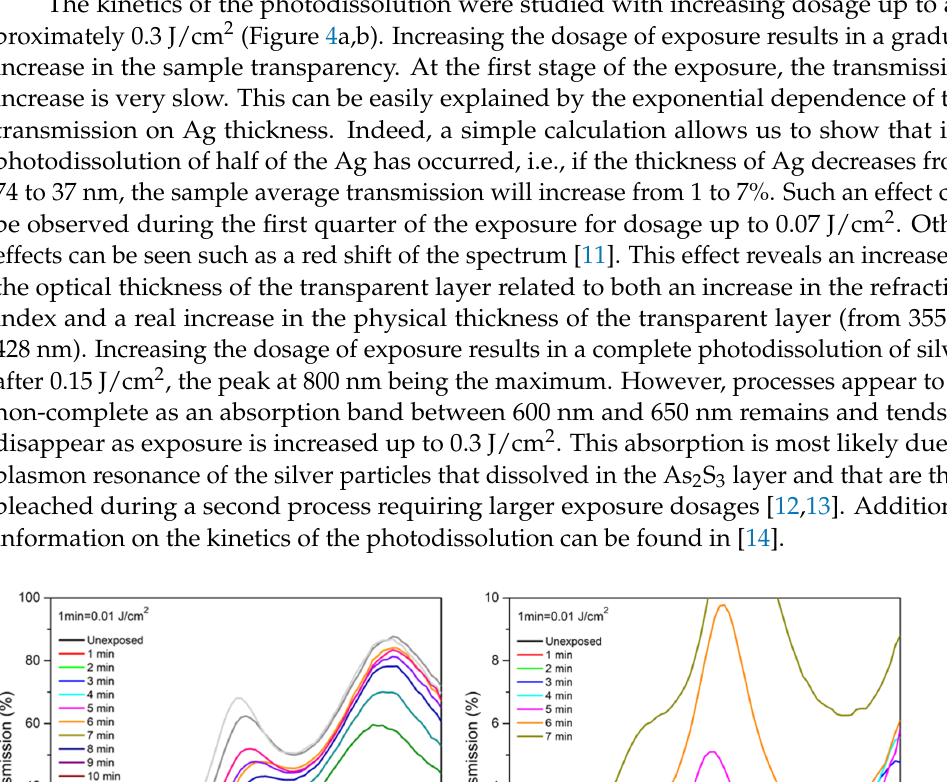
Figure 3. Optical setup for the direct femtosecond laser writing of CGHs through photodissolution.